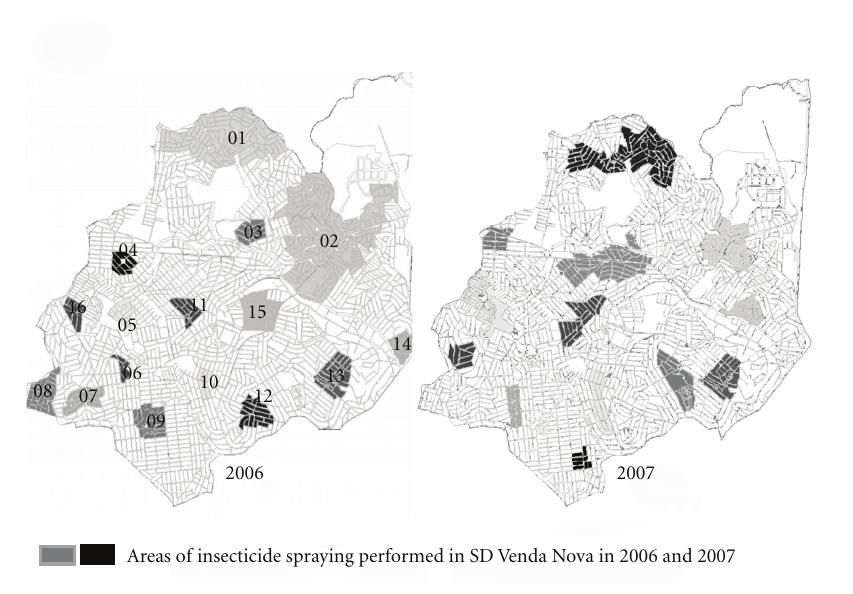
Figure 2: Example of the geographical pattern of areas scheduled for insecticide spraying in SD Venda Nova in the years from 2006 to 2010. The areas shown were planned for the years 2006 and